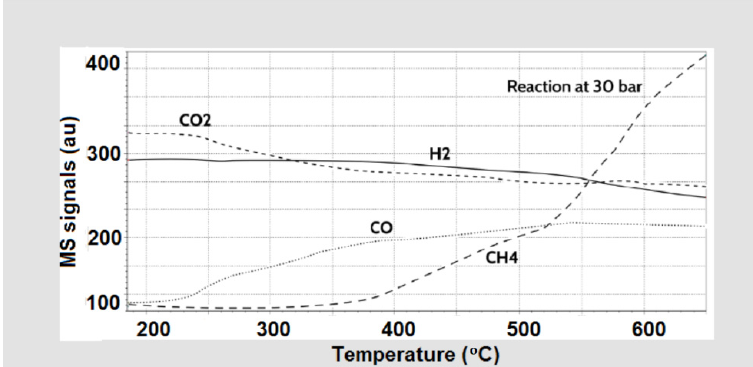
Figure 7. Spectrum of signals at 30 bar.